Question: Draft a figure caption describing what is shown.
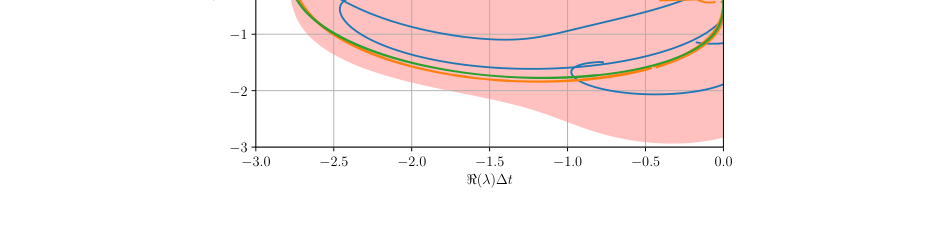
Answer: Stability conditions for a two-fluid explicit RK4 DG solver for the above specified conditions. The red highlighted region is the region of absolute stability for RK4 and the curves define the stability eigencurves of the ideal two-fluid system generated using the method from section 2. Implicit simulations were run with ∆t = 6.28×10−3 to achieve sufficient temporal resolution for the Fourier dispersion analysis in Figure 8. A degree 0 basis could be run explicitly with this timestep; however, an explicit solution with a high degree basis is unstable using this timestep.